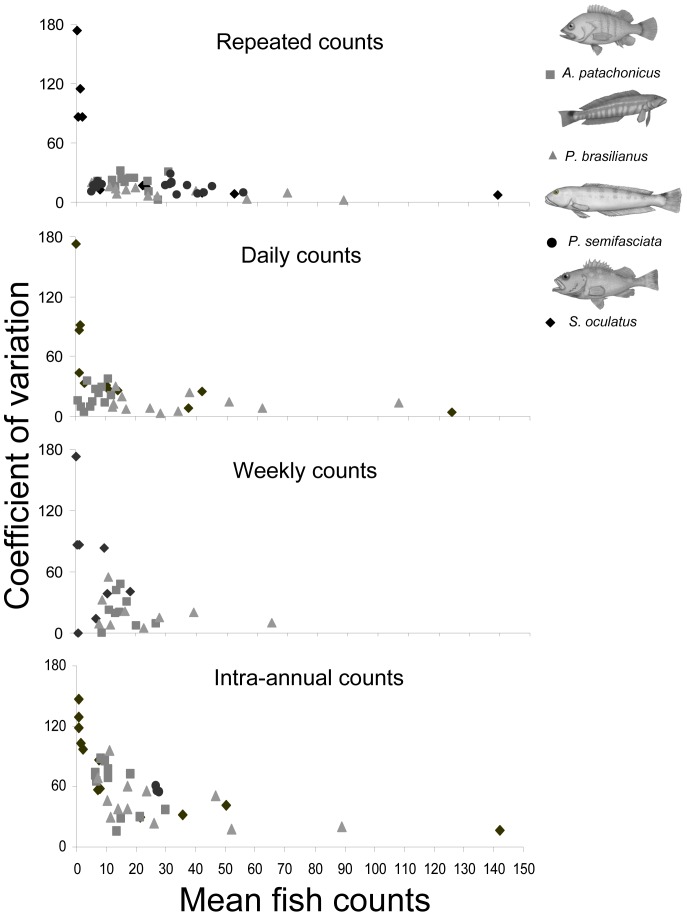
Coefficients of variation versus mean fish counts.Empirical coefficients of variation versus mean fish counts for each temporal scale studied. Each point corresponds to one transect or reef.